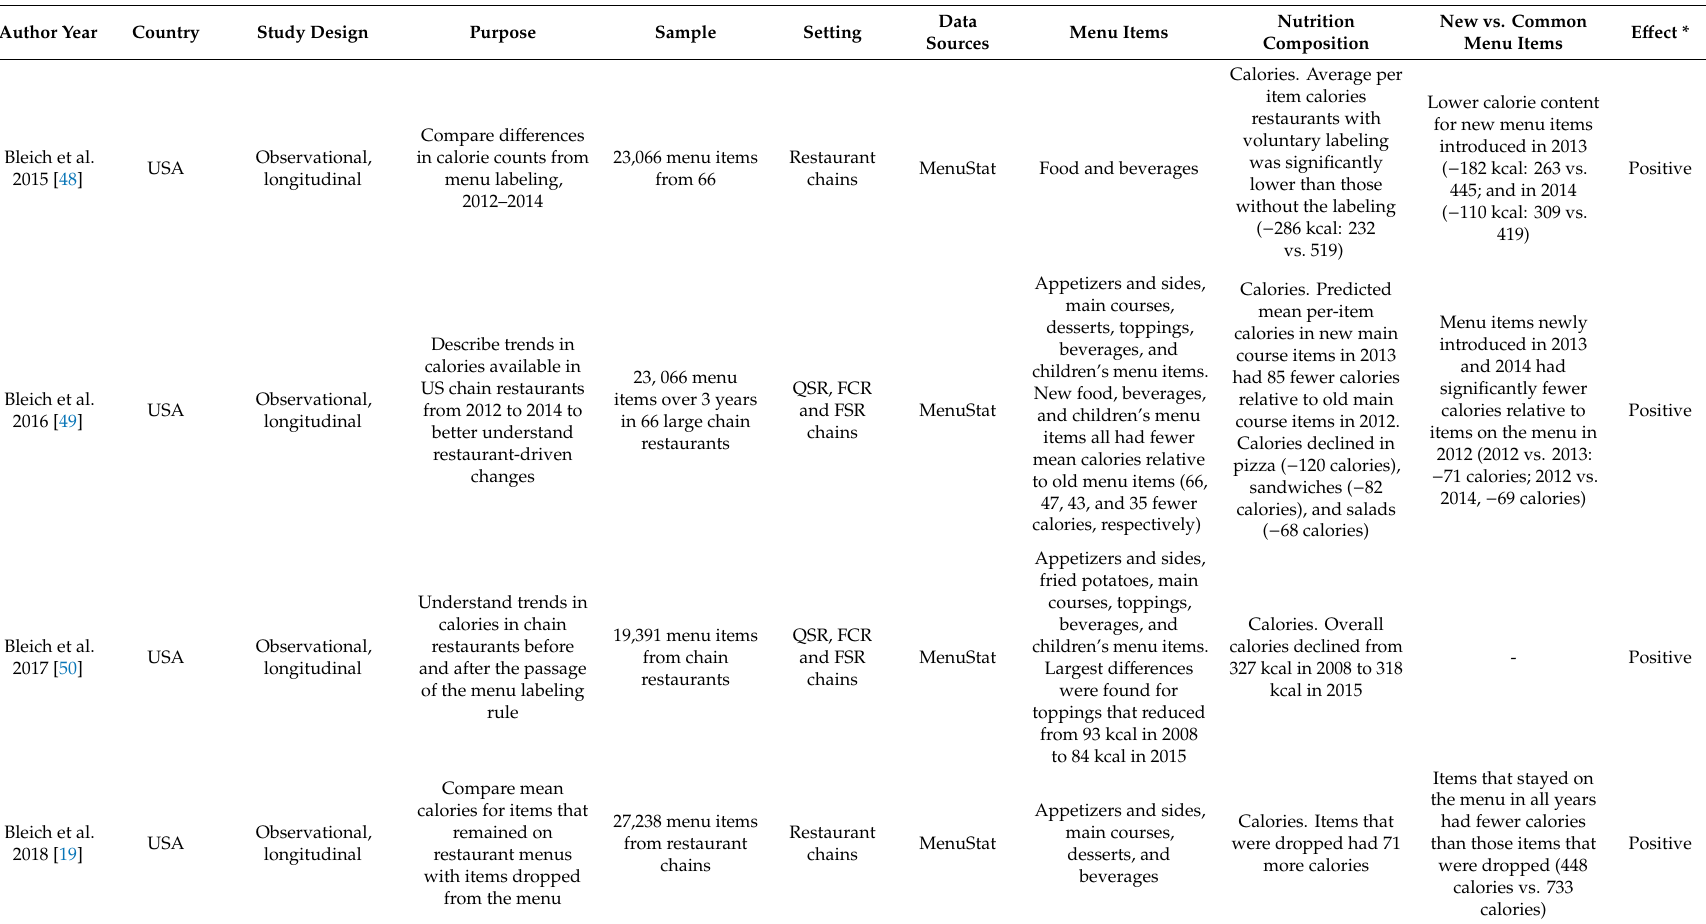
Table 4. Summary of articles included in the scoping